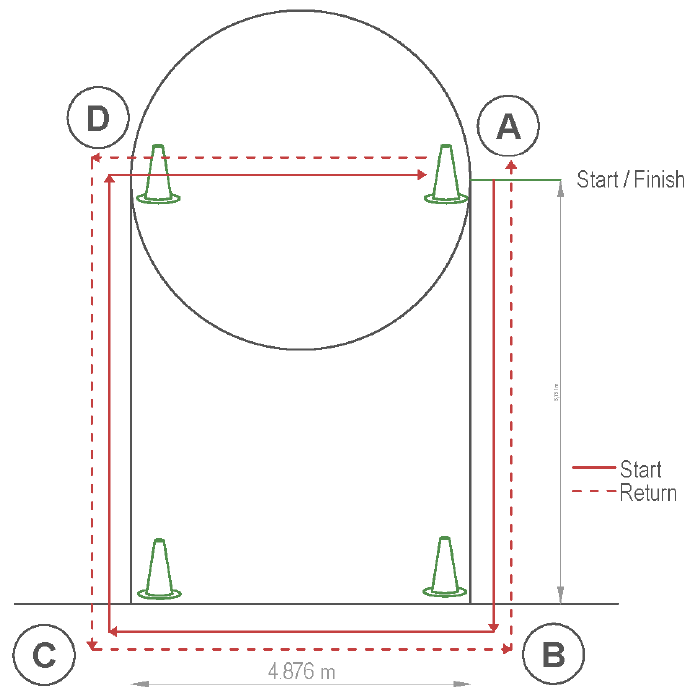
Figure 3. Lane Agility test; adapted and edited from [29] .